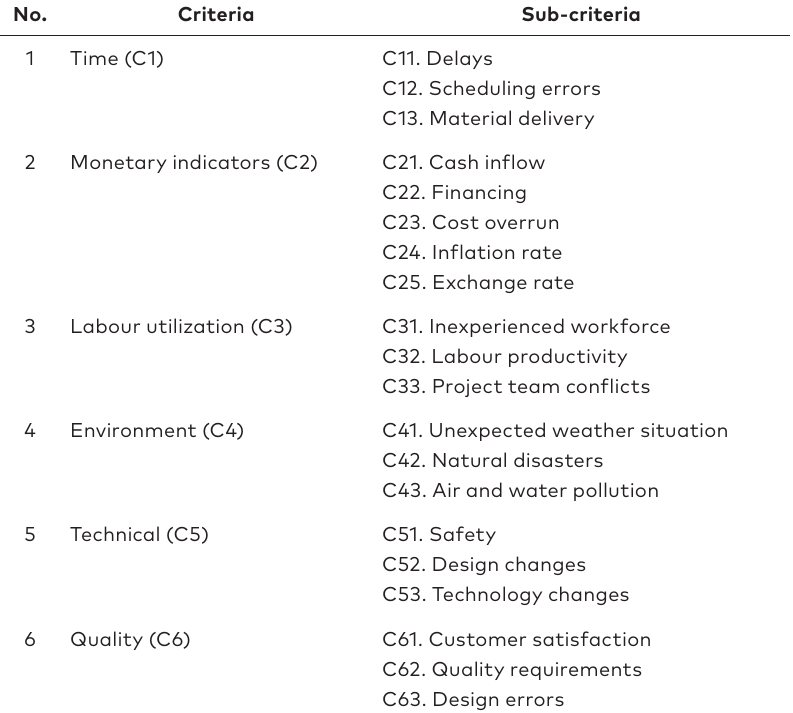
Table 3. Structure of the decision